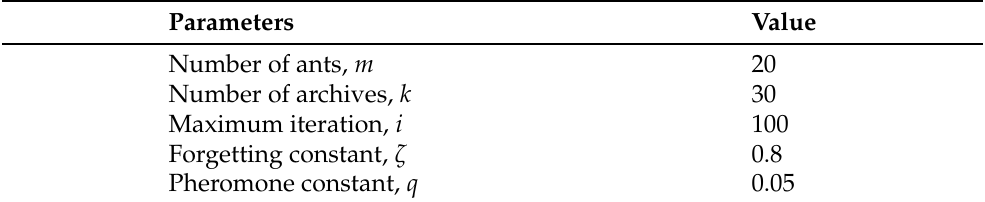
Table 3. ACO setup parameters.